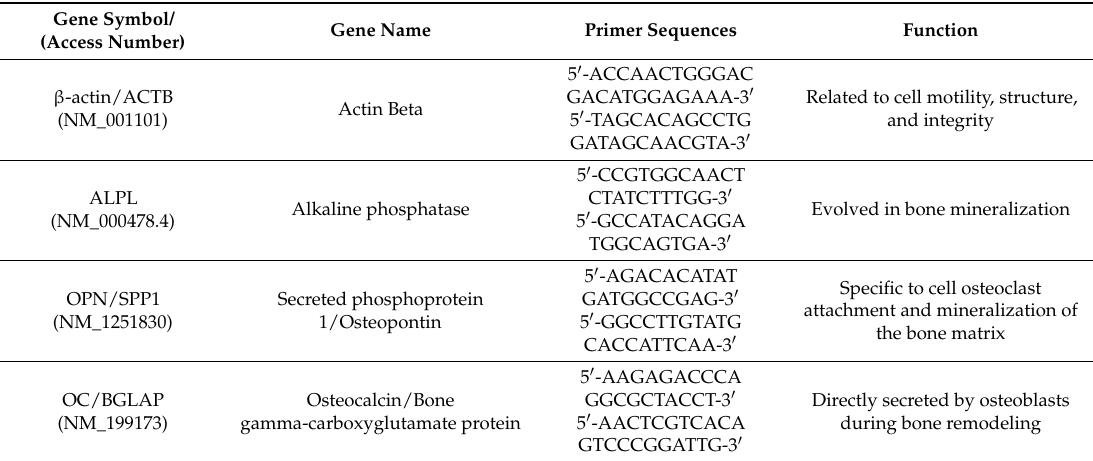
Table 1. Details of gene-specific used in RT-qPCR